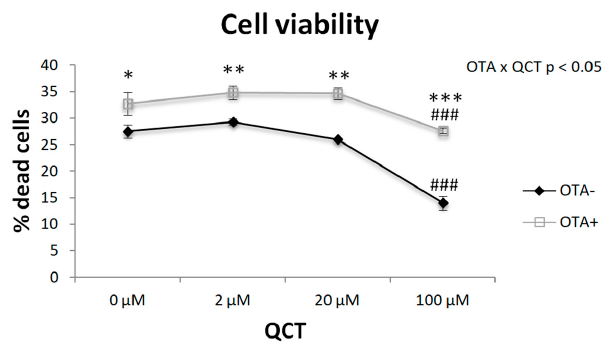
Figure 1. E ff ect of quercetin (QCT) at various concentrations with (OTA + ) or without the addition of ochratoxin A (OTA-) in cell culture medium on the viability of di ff erentiated primary rat preadipocytes. Cell viability was determined using a commercially available kit. The results, presented as mean ± mean error (SEM), were analyzed by two-way ANOVA with factors QCT and OTA, followed by Bonferroni post-hoc test. The level of statistical significance was considered for factor OTA * p < 0.05; ** p < 0.01; *** p < 0.001; and for factor QCT ### p <